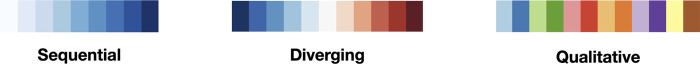
Example of 3 color palettes according to the 3 main data types.These color palettes are based on the ColorBrewer schemes. They comprise different classes and are given specific names in ColorBrewer: sequential (9-class Blues), diverging (11-class RdBu), and qualitative (12-class Paired).